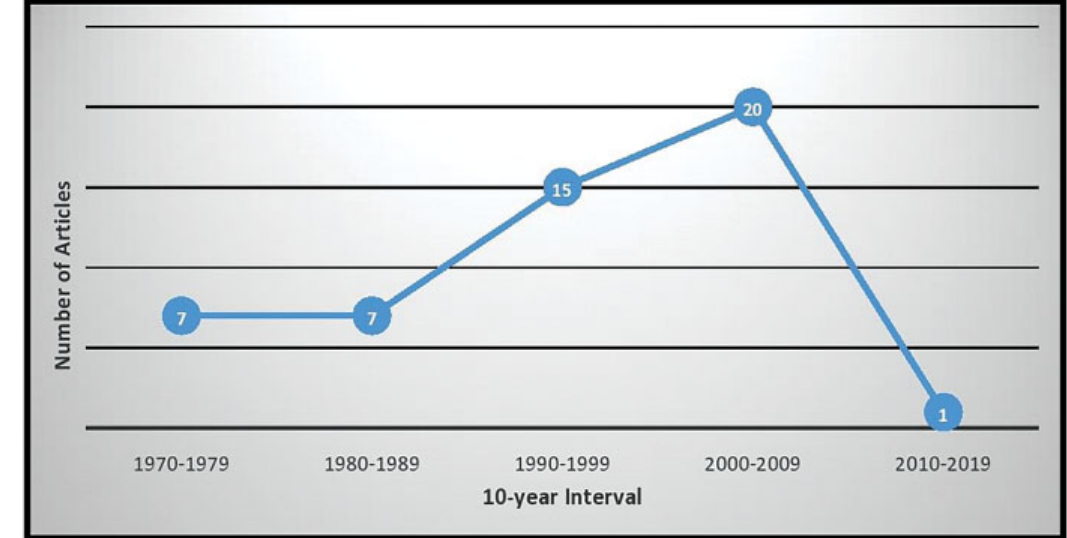
Fig. 3 Distribution of articles on the basis of 10-years